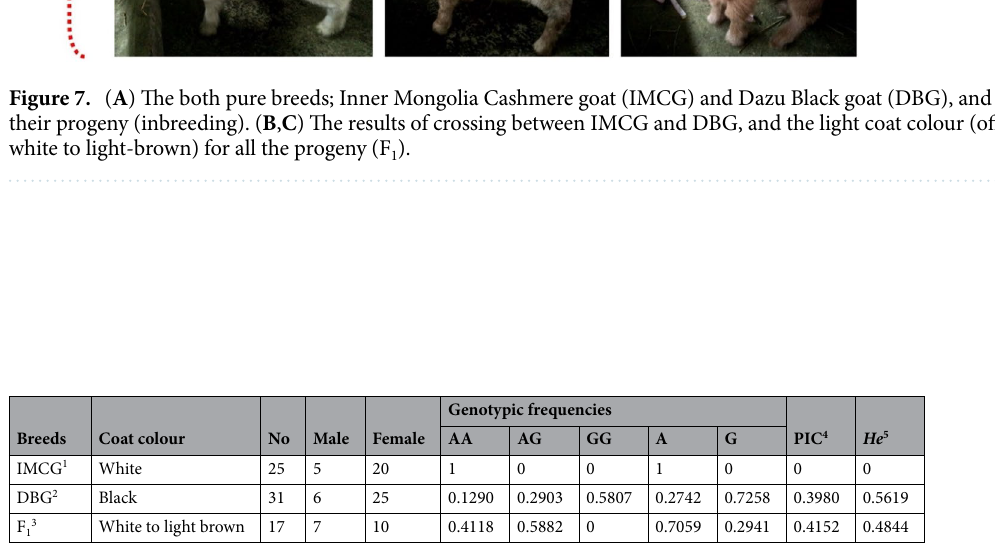
Table 5. Genotypic and gene frequency of rs647214940 site( KIT gene). 1 IMCG Mongolia Cashmere goat, 2 DBG Dazu black goat, 3 F 4 PIC polymorphism information content, 5 He 1 IMCG x DBG cross,